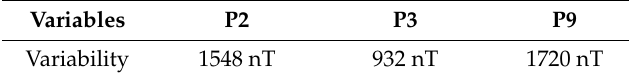
Table 9. Statistical Time Significances.